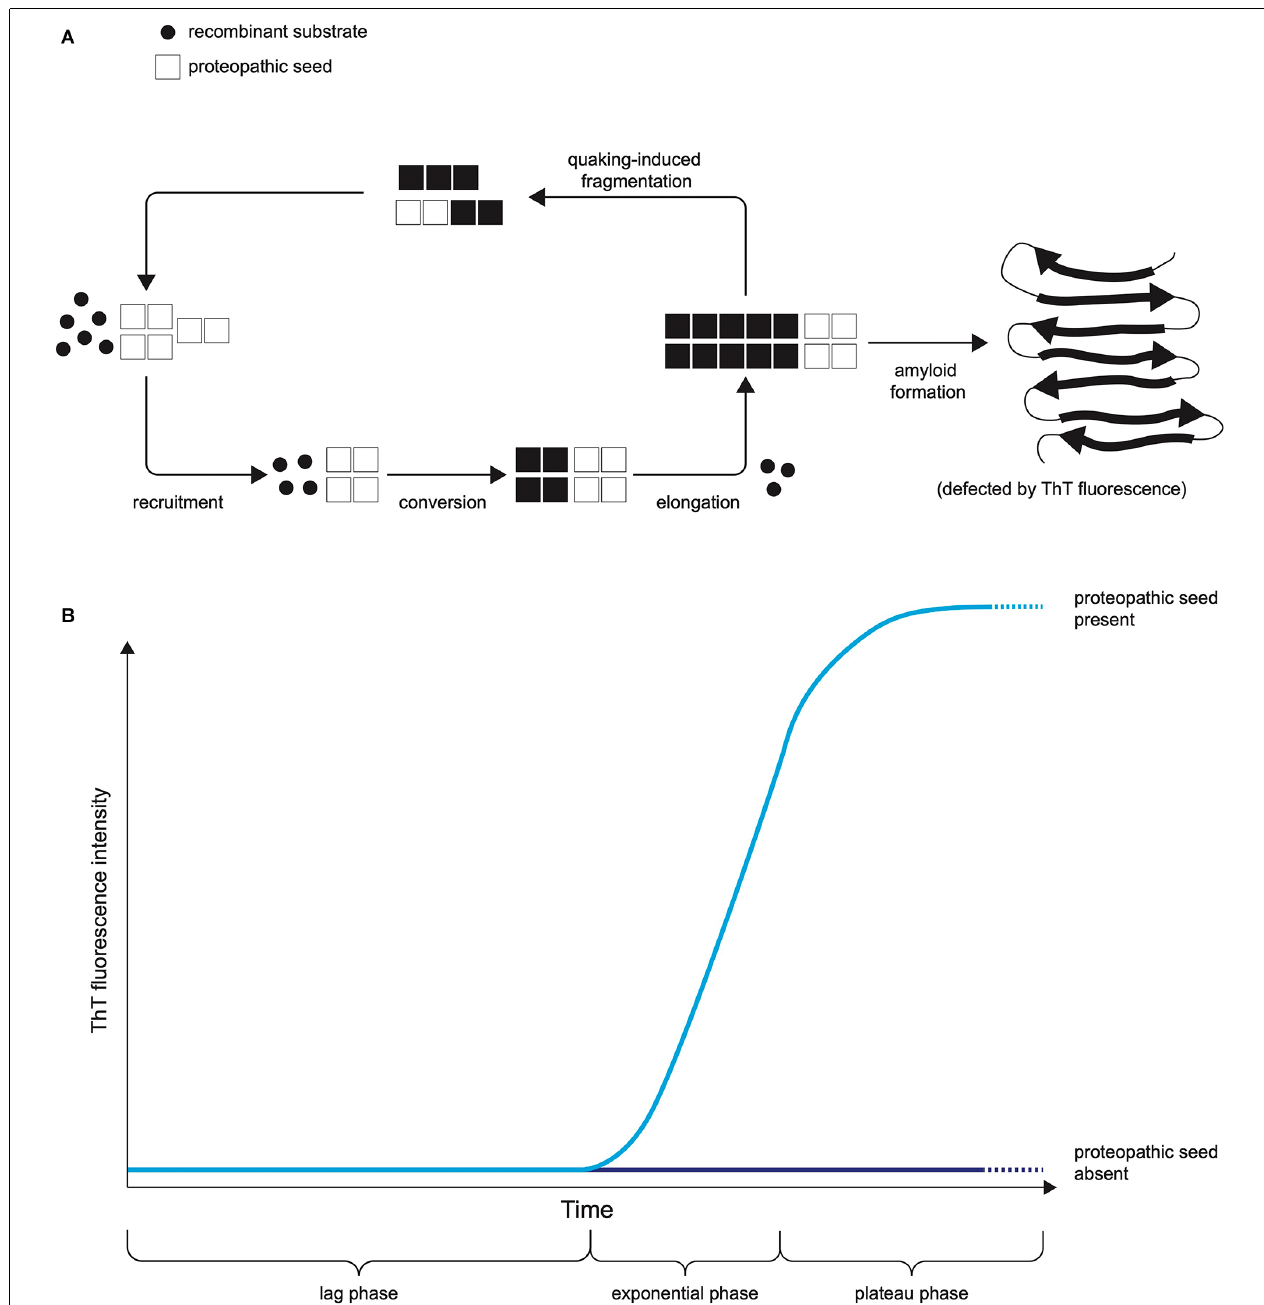
FIGURE 1 | The Principle of RT-QuIC. (A) The mechanistic principle of proteopathic seed amplification using multiple cycles of incubation and quaking-induced fragmentation resulting in beta-sheet rich amyloid formation. (B) Schematic representation of RT-QuIC readout due to ThT fluorescence as protein amyloid accumulates. The kinetics of the RT-QuIC readout (rate of rise, maximum fluorescence, lag phase) may vary according to the type of proteopathic seed and its quantity, as well as assay conditions including temperature, shaking parameters, the composition of reaction mix, and choice of